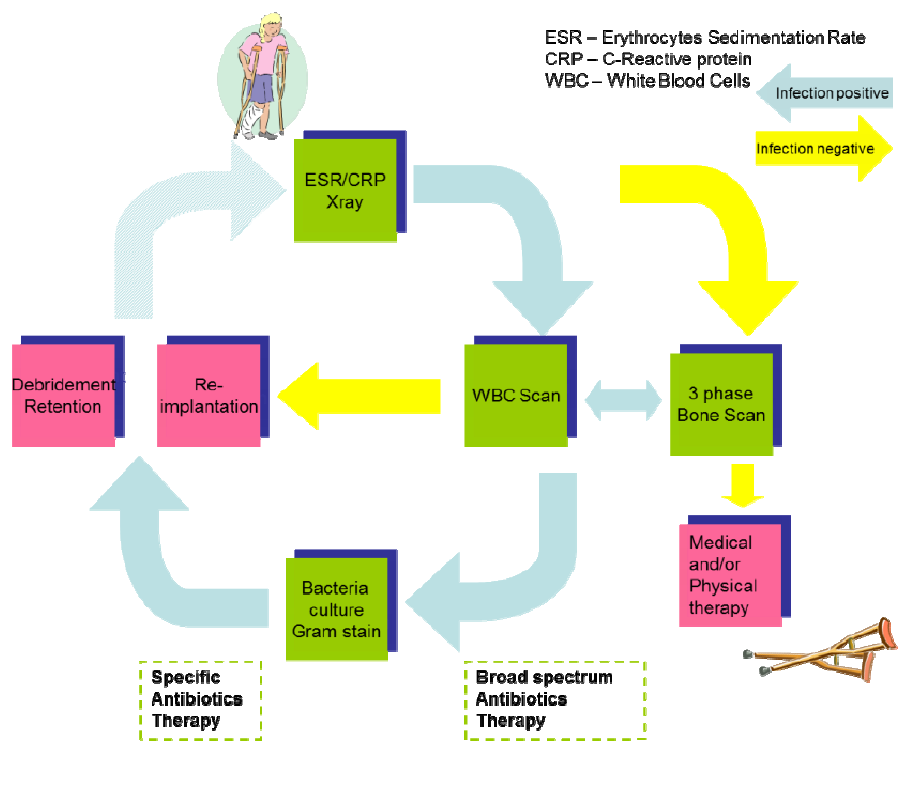
Figure 2. Flow chart of infection diagnosis in